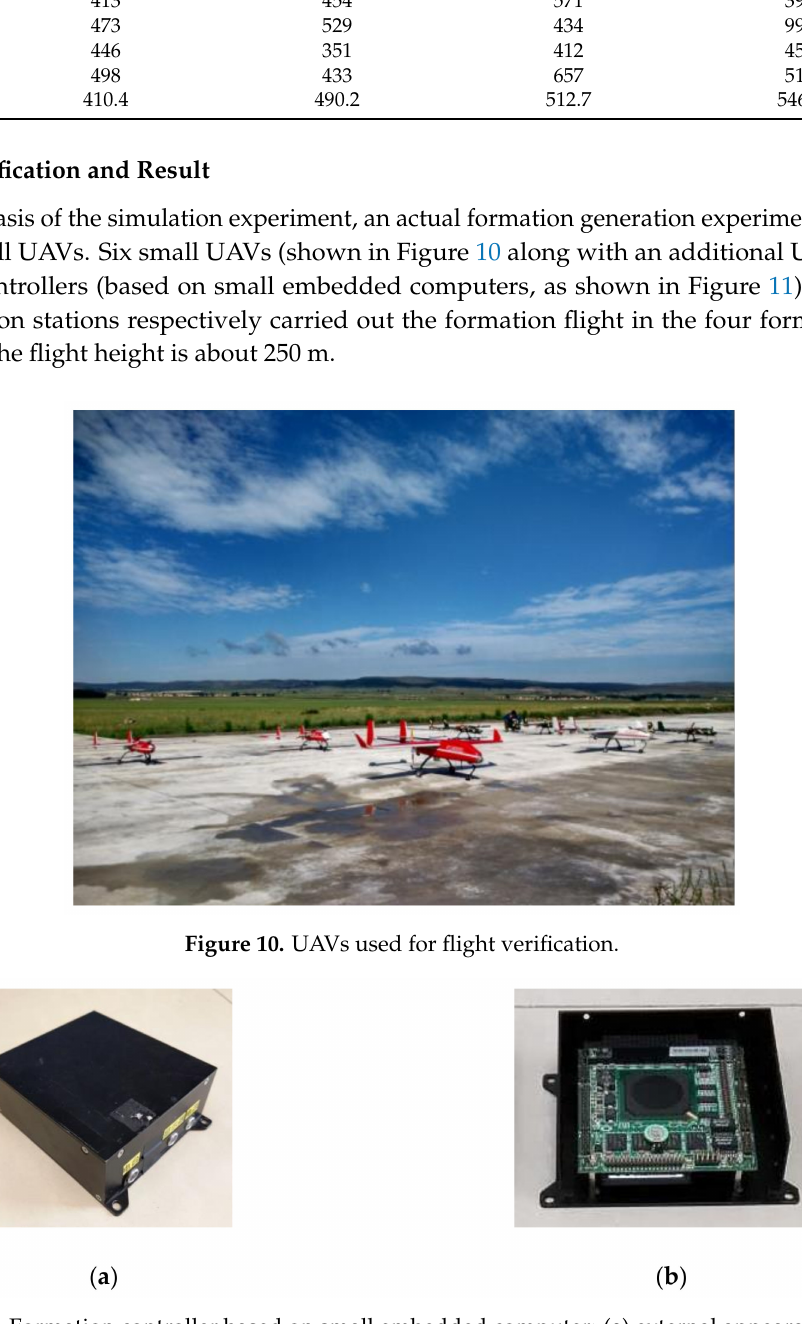
Figure 11. Formation controller based on small embedded computer: ( a ) external appearance of the formation controller; ( b ) internal structure of the formation